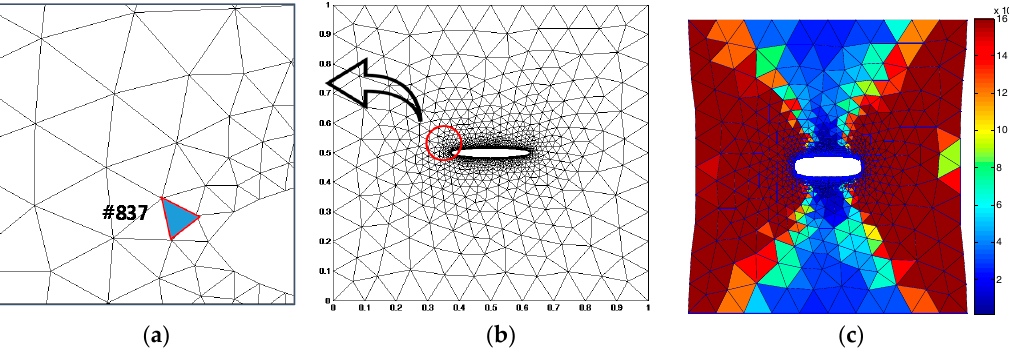
Figure 12. Two-dimensional metal panel problem with slit-like defect: ( a ) elements monitored, ( b ) finite element mesh layout and ( c ) von Mises stress contour plot. Table 1. Computation (CPU) time for different time integration schemes (unit: second(s)). Time Integration Schemes